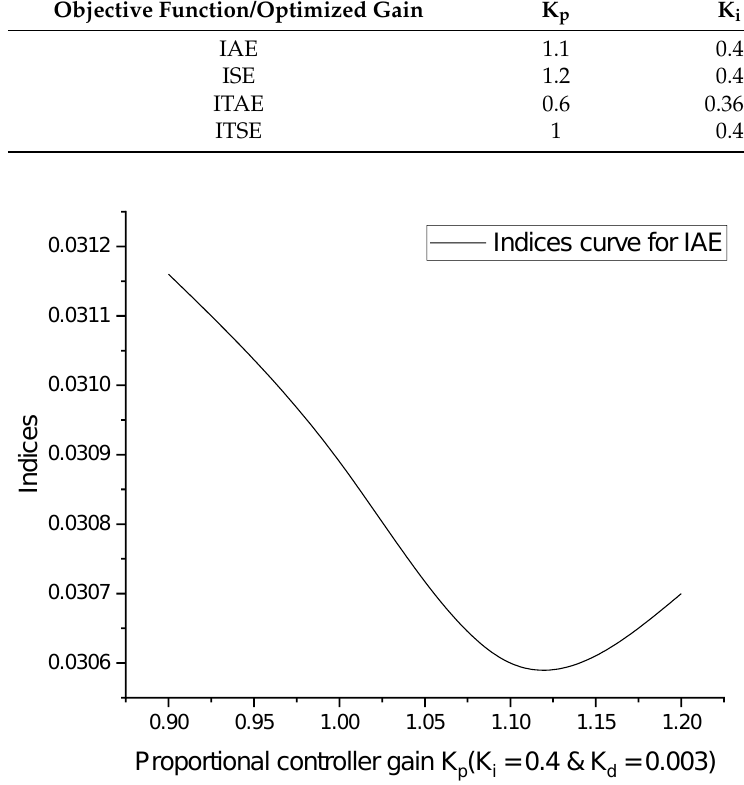
Proportional controller gain K Figure 2. IAE performance indices Figure 2. IAE performance indices curve.